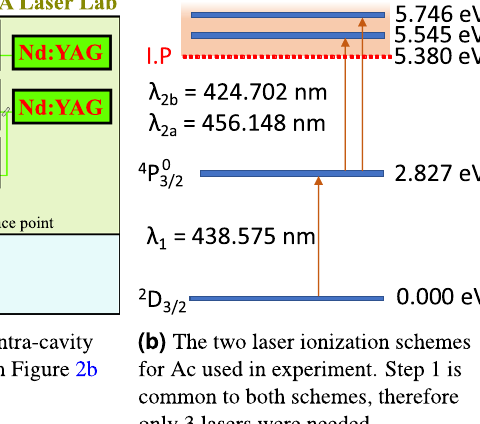
Figure 2. The experimental setup and ionization scheme used for 225 Ac collections at MEDICIS in this